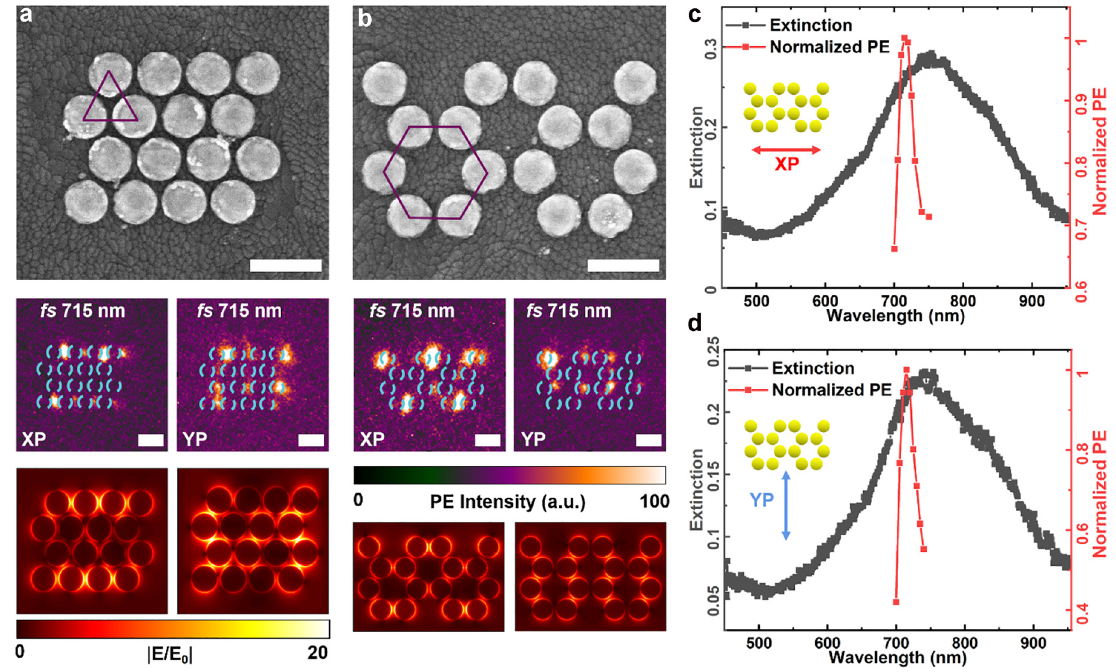
Figure 5: Experimental and simulated results of triangular and honeycomb lattice. (a, b) SEM images of the plasmonic meta-arrays with triangular and honeycomb lattices. Experimental near-field images and simulated electric field distributions are shown for XP (left panels) and YP (right panels) excitations. The excitation wavelengths are 715 nm at their peak wavelength, and the scale bar represented by a short white line in each figure represents 200 nm. (c, d) Spectra of far field and near field under XP and YP excitation in the honeycomb lattice respectively. The wavelength range of the figures is from 450 nm to 955 nm. The red two-way arrow indicates the XP light and the blue two-way arrow indicates the YP